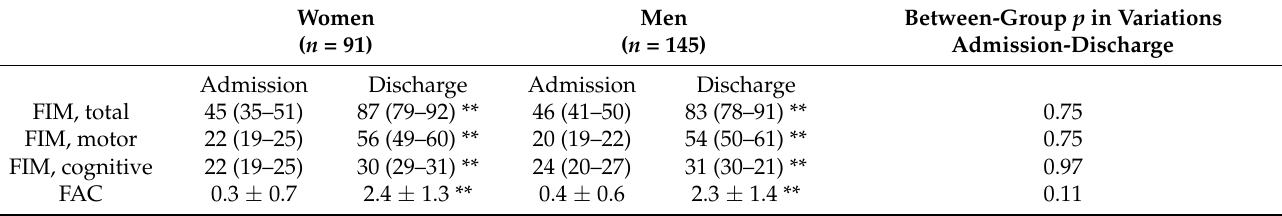
Table 2. Outcomes of the study for the two groups.